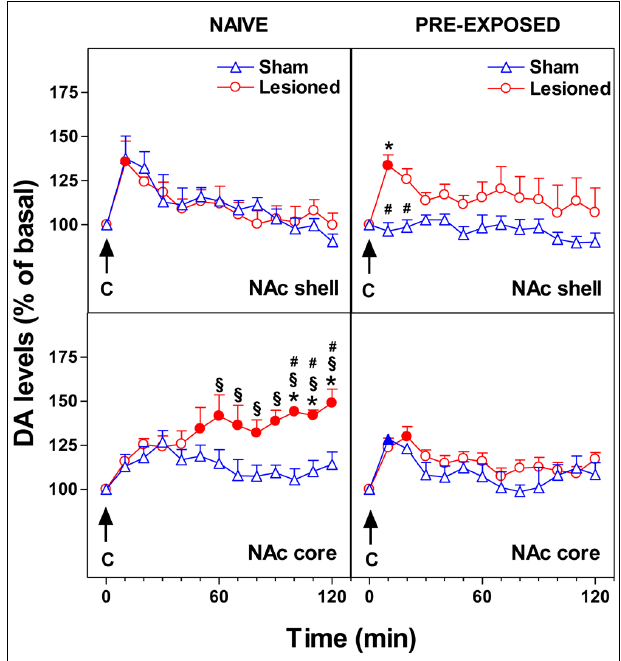
FIGURE 2 | Effect of 24-h pre-exposure to chocolate (C, 1 ml/5 min, i.o.) on NAc shell and core dialysate DA in 6-OHDA lesioned in the mPFC or control rats. Results are indicated as mean ± SEM of change in DA extracellular levels expressed as the percentage of basal values. Solid symbol, p < 0.05 vs basal value; *, p < 0.05 vs Sham; #, p < 0.05 vs Lesioned pre-exposed; §, p < 0.05 vs Sham pre-exposed. (Adapted from Figure 6; Bimpisidis etal.,